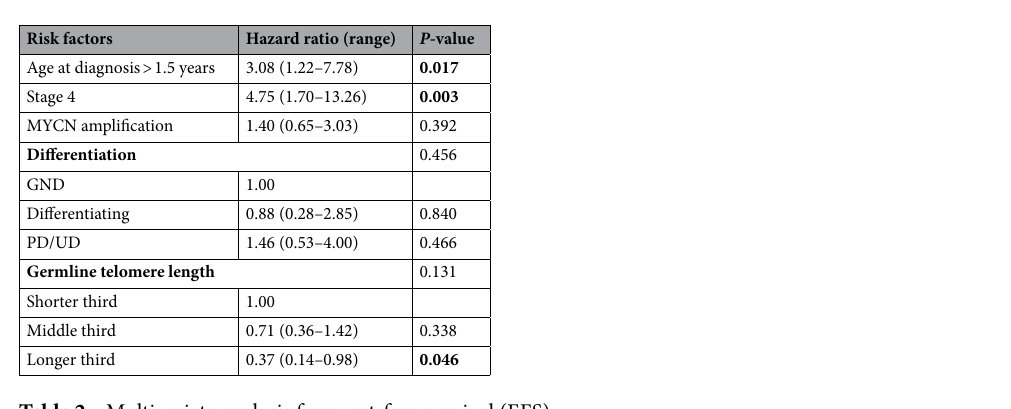
Table 2. Multivariate analysis for event-free survival